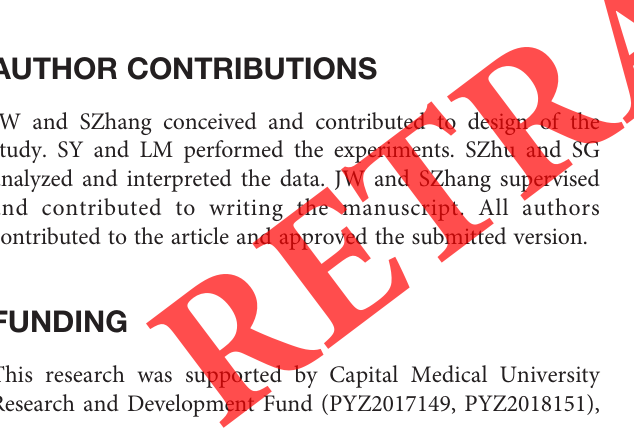
FIGURE 8 | Upregulation of epithelial cell transforming 2 (ECT2) activates EGFR signaling via GRB2 deubiquitination and promote